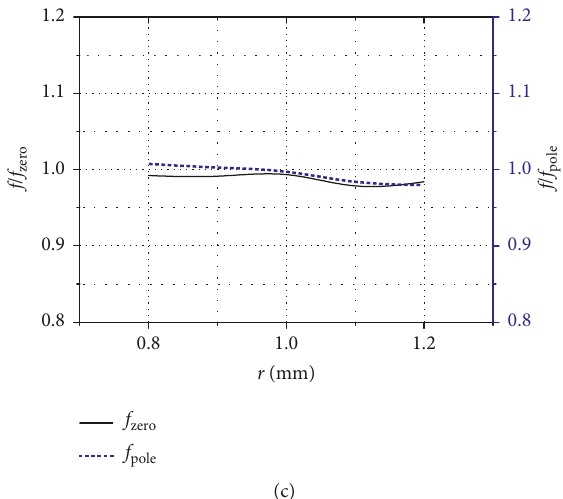
Figure 4: Dual-post resonator design curves example. Transmission zero and pole frequencies as a function of (a) the resonator distance for r 1 � 1mm, h 1 � 1.4mm, and h 2 � 2.4 mm; (b) resonator height difference for r 1 � 1mm and d � 4.67mm; and (c) resonator radii for